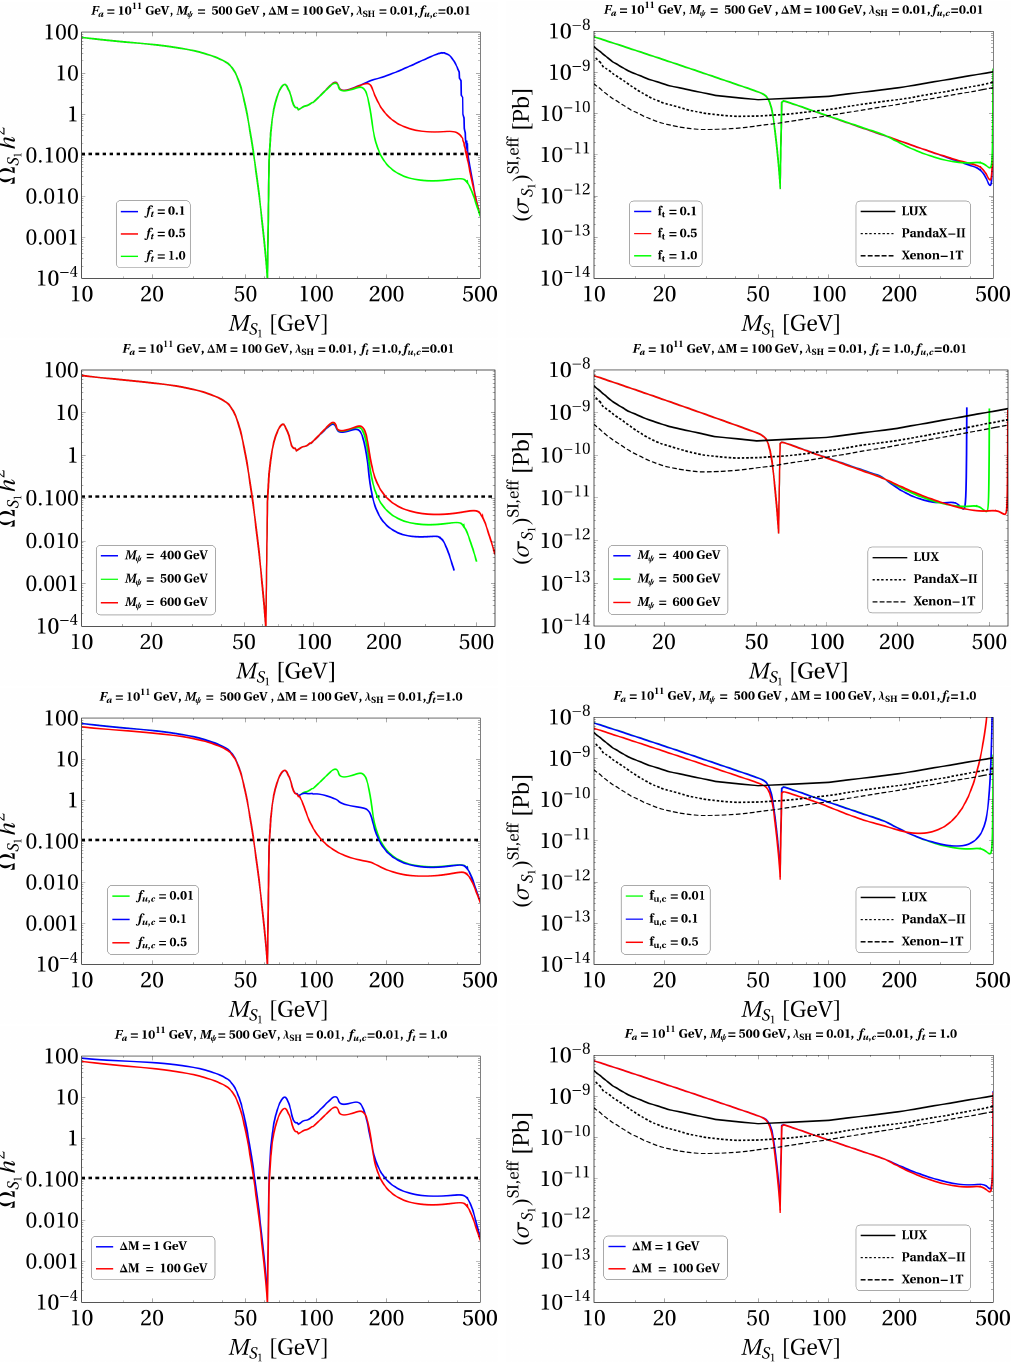
(right panel) versus dark matter mass M h 2 (left panel) and σ SI S 1 , eff 1 = 10 11 GeV , λ = 0 . 01 . The Black dashed line in all the left plots a SH 2 a h